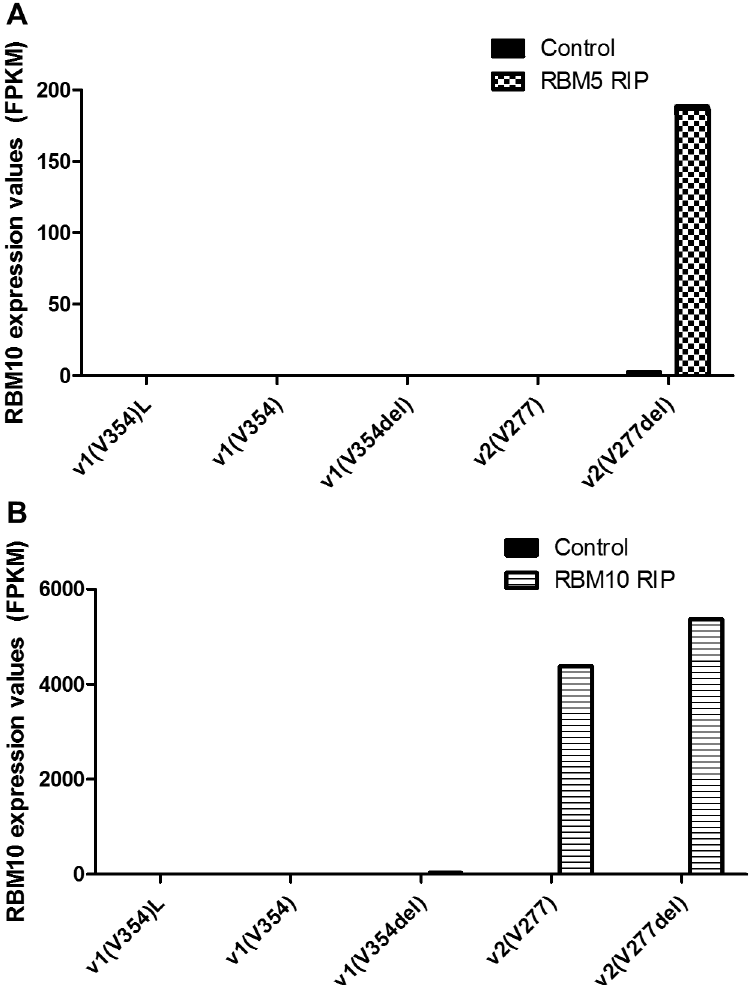
Fig 7. RBM5 and RBM10 RIP-Seq results for RBM10 splice variants. Graph representing the expression of the various RBM10 splice variants in RBM5 (A) and RBM10 (B) RIP-Seq experiments, which were carried out in C4